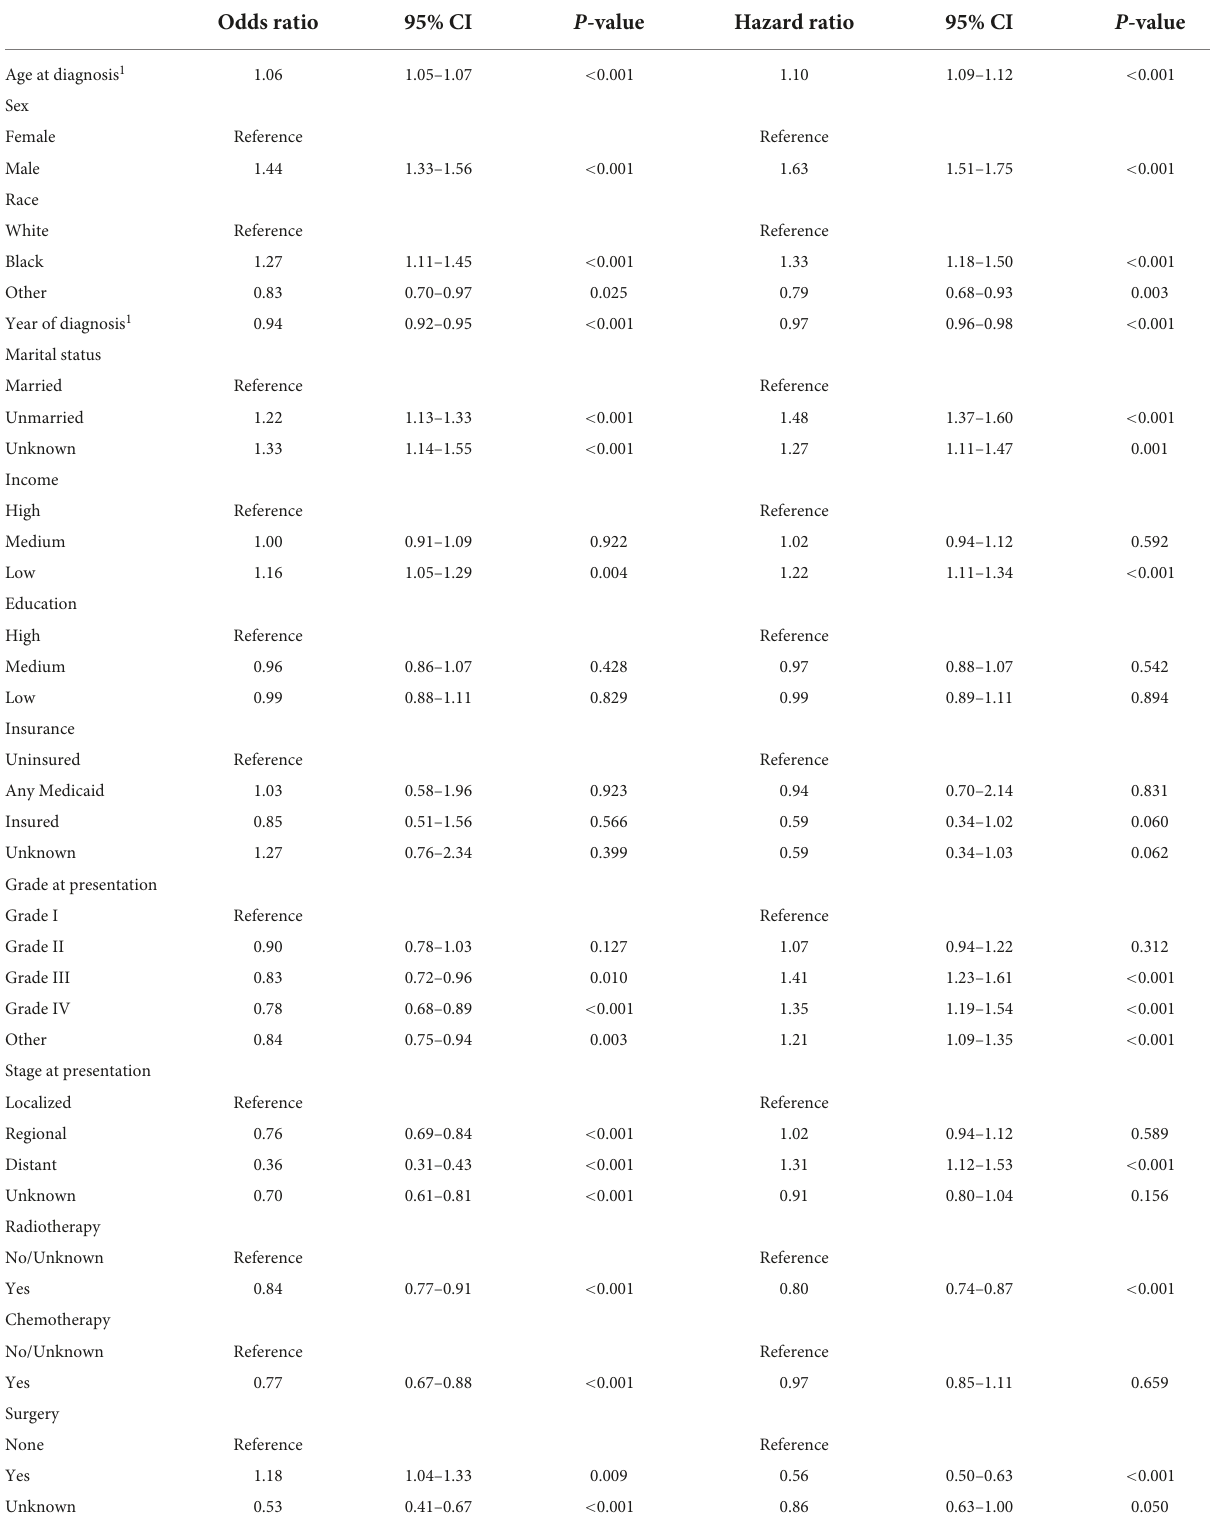
TABLE 5 Odds ratios and hazard ratios of fatal HD among sarcoma